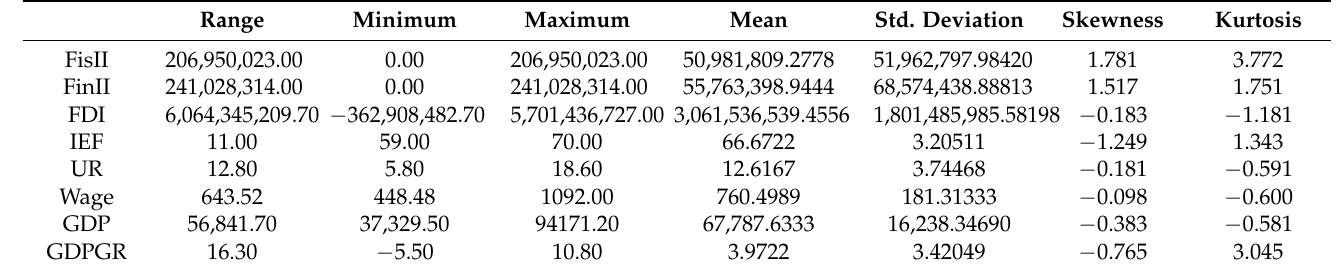
Table 1. Descriptive statistics.